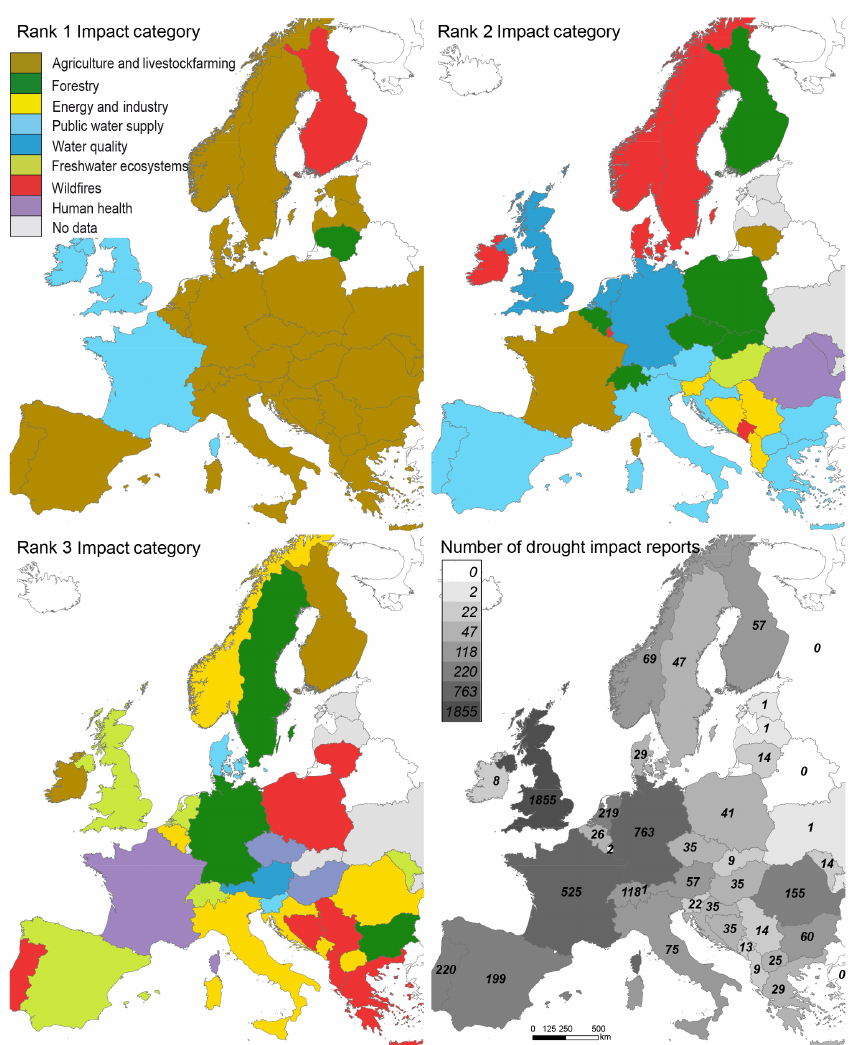
Figure 3. EDII contents by country: top three (most frequently reported) impact categories (Ranks 1–3) and the total number of drought impact reports in the